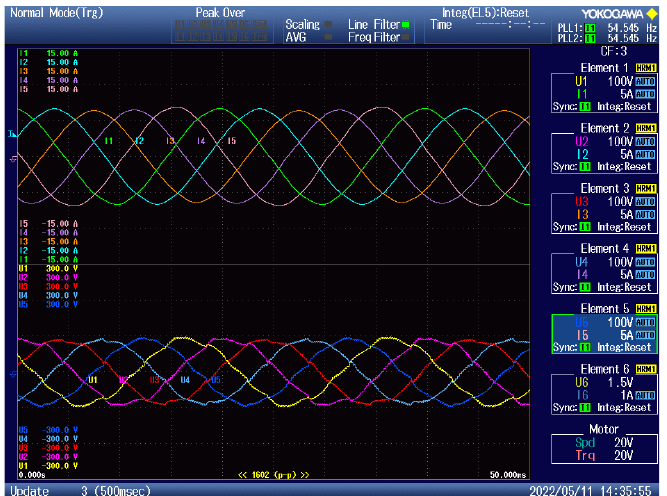
Figure 13. Measured five phase output of the MxC prototype (phase currents—top and phase voltages—bottom)—Software Filtered.